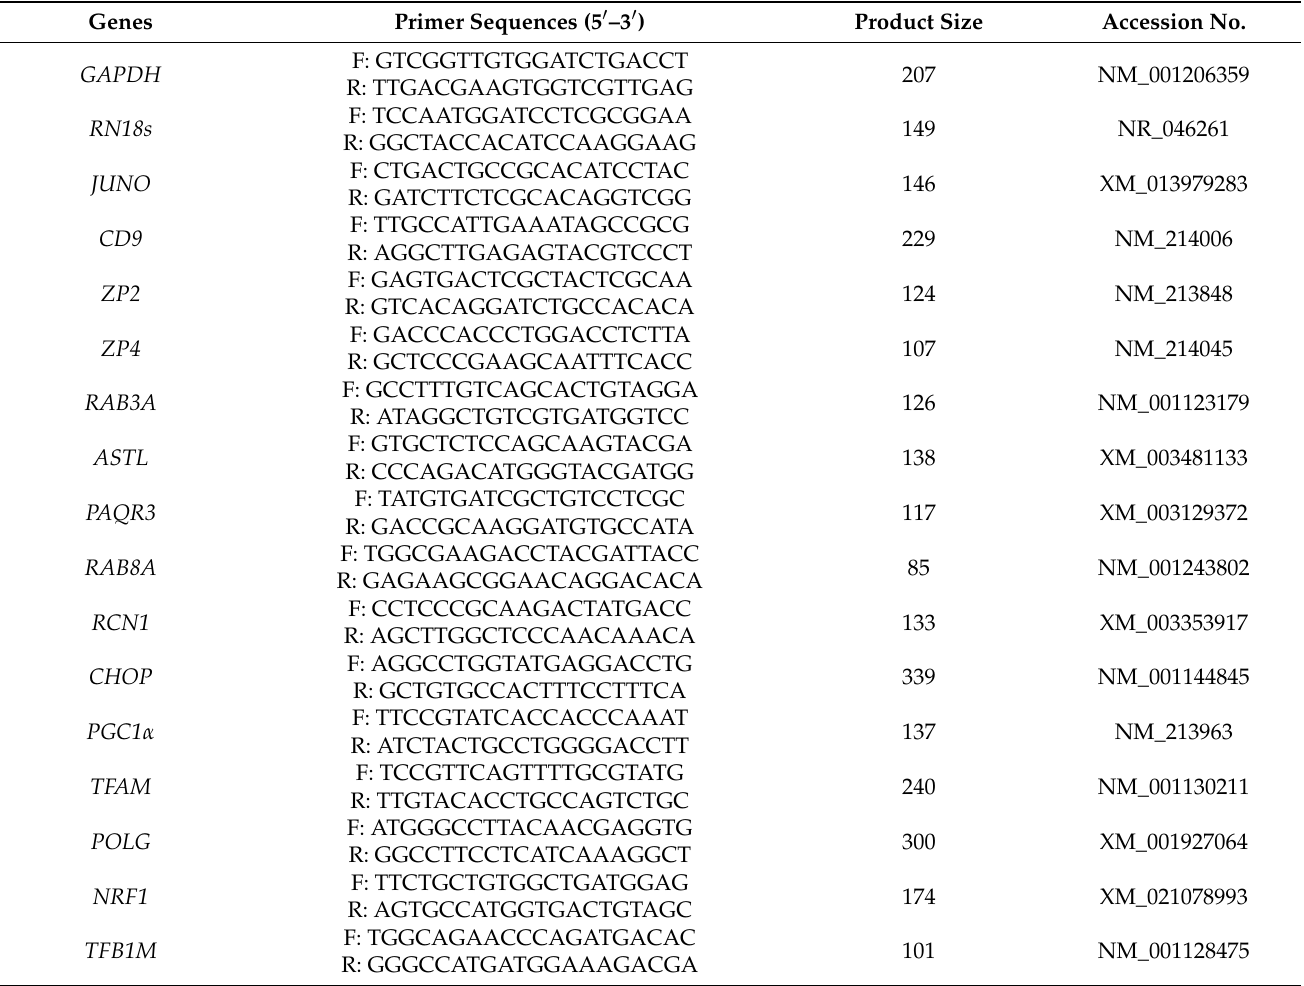
Table 1. Primer sequences used for real-time